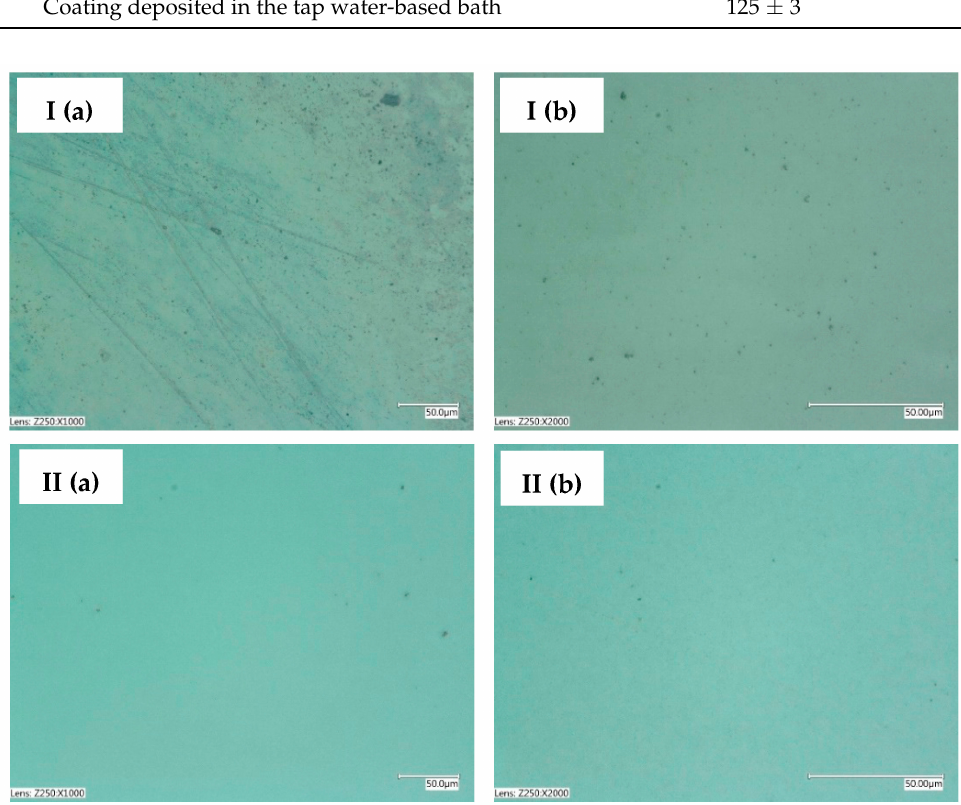
Figure 5. Surface morphology presented in optical microscope images (( a )—magnification × 1000, ( b )—magnification × 2000) of zinc coatings obtained from ( I ) the RO retentate-based bath and ( II ) tap water-based bath.